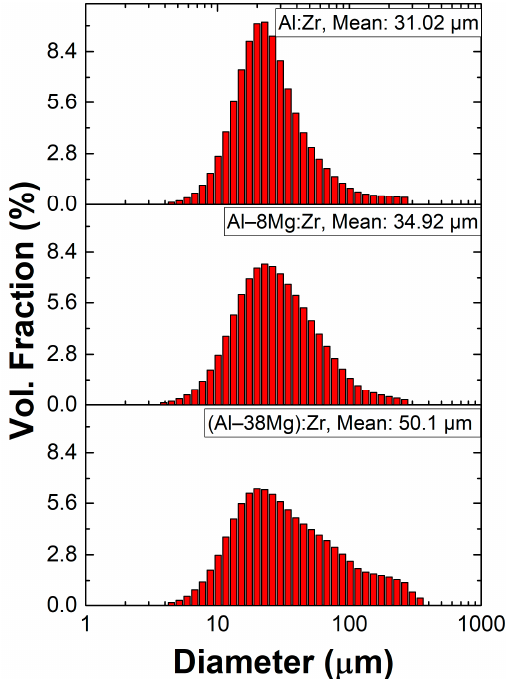
Figure 2. Ball milled particle size distributions for Al:Zr, Al-8Mg:Zr, and Al-38Mg:Zr compositions.